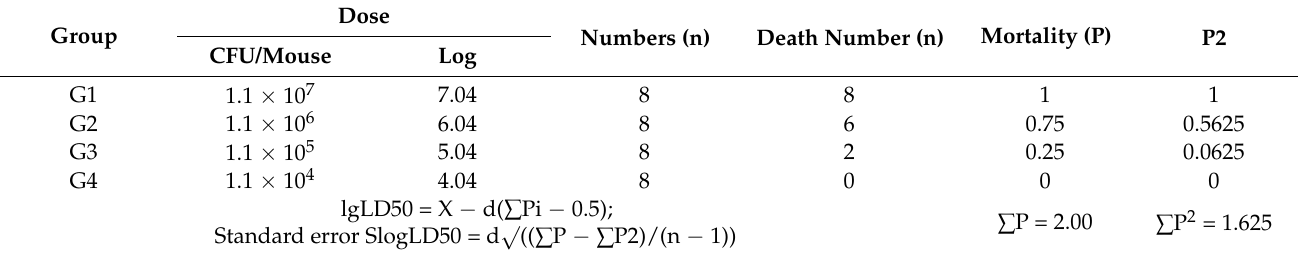
Table 1. Experimental data on the pathogenicity of A. veronii YL4077 in mice. Dose Group